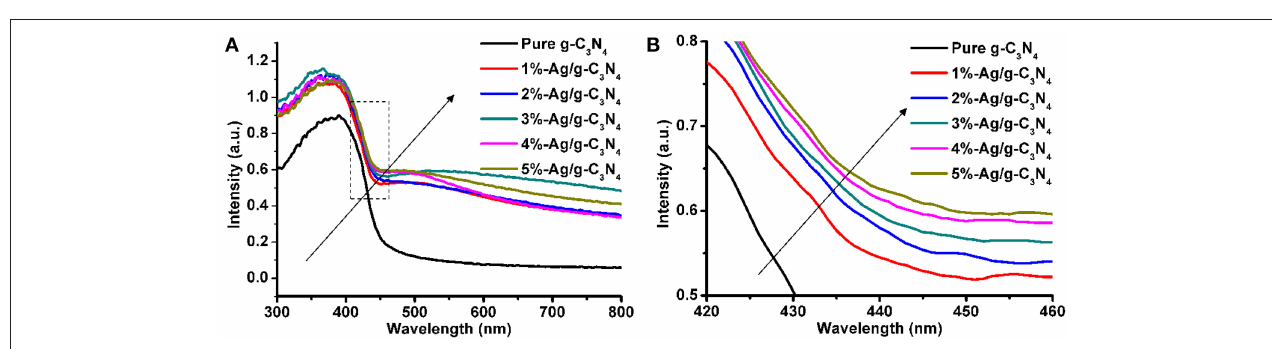
FIGURE 5 | (A) UV-Vis diffuse reflectance absorption spectra of the pure g-C 3 N 4 and Ag/g-C 3 N 4 samples. (B) Magnify the square apart of picture (A) .